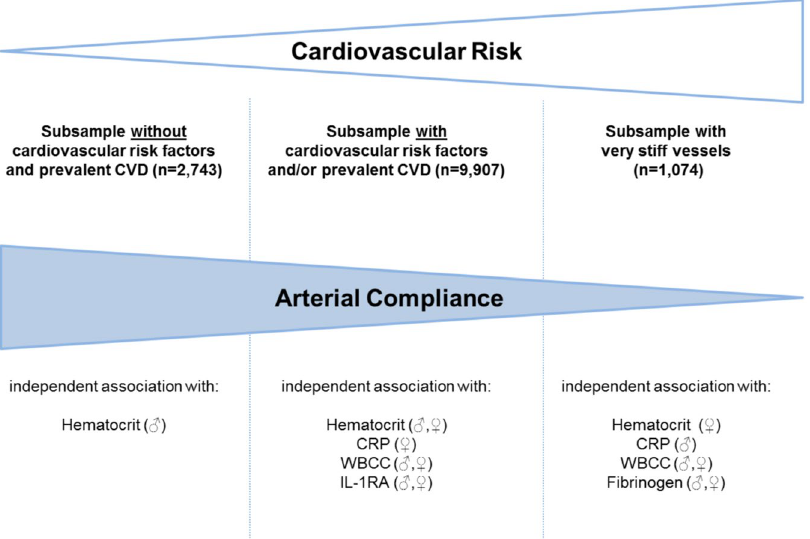
Figure 5. Differential Impact of Markers of Inflammation and Hemostasis on Arterial Compliance According to Cardiovascular Risk Profile. CVD stands for cardiovascular disease, CRP for C-reactive protein, WBCC for white blood cell count, and IL-1RA for interleukin-1 receptor